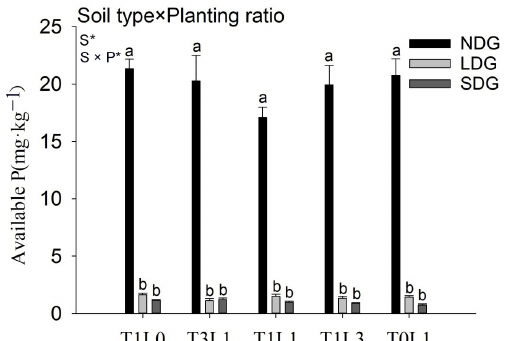
ratio (P) and their interactions (S × P) on soil nitrate nitrogen concentration. ( b ) Effects of biological